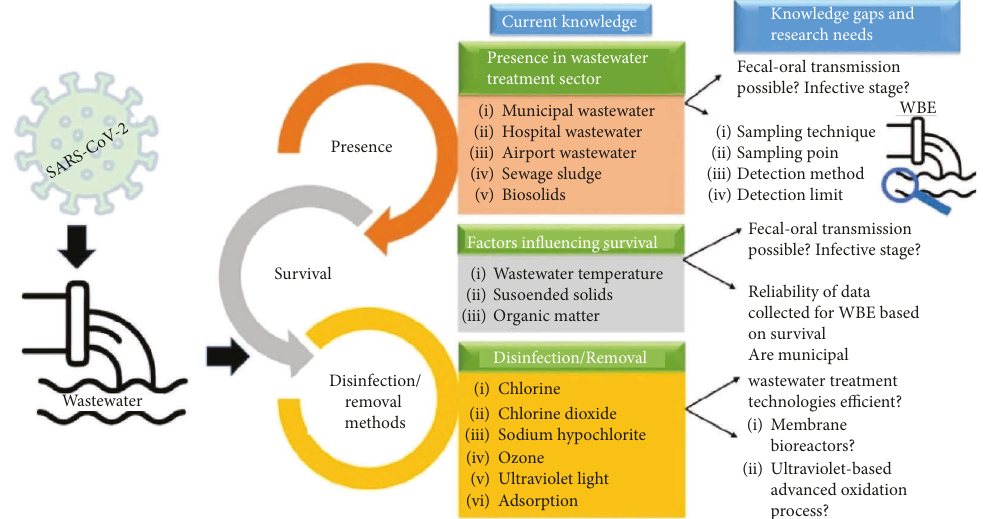
Figure 2: Features of SARS-CoV-2 in wastewater